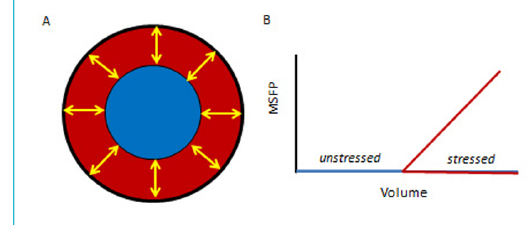
Figure 2: Stressed and unstressed vascular volume. The vol- ume inside a vessel at near zero transmural pressure is termed “unstressed volume” (blue). It fills the system without exerting ten- sion in the vessel wall. The blood volume that creates positive transmural pressure via the elastic recoil of the vessel wall is termed “stressed volume” (red). Stressed volume is a function of mean systemic filling pressure and vascular compliance. (A) Cross section of a blood vessel. (B) The relationship between blood vol- ume and MSFP. Figures adapted from references